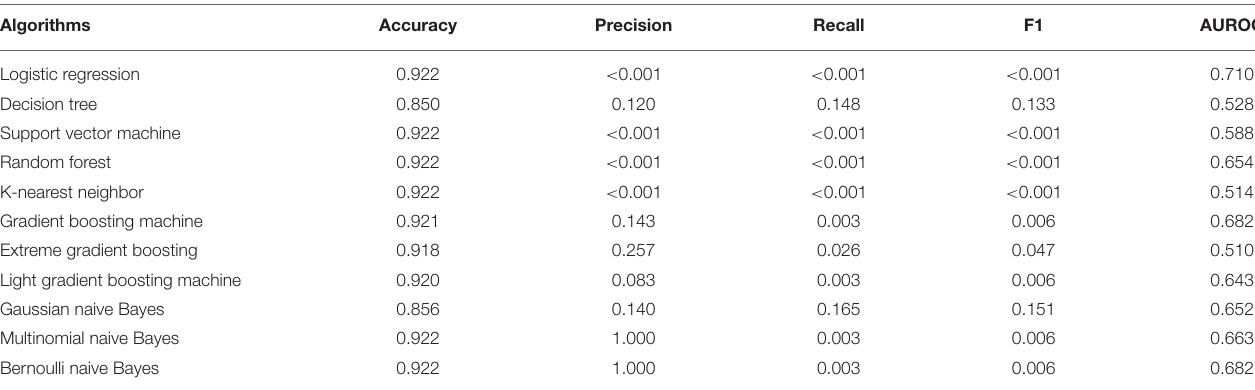
TABLE 2 | Prediction performance of 11 machine learning algorithms for lower respiratory tract infection using accuracy, precision, recall, F1 score and area under the receiver operating characteristic curve (AUROC).